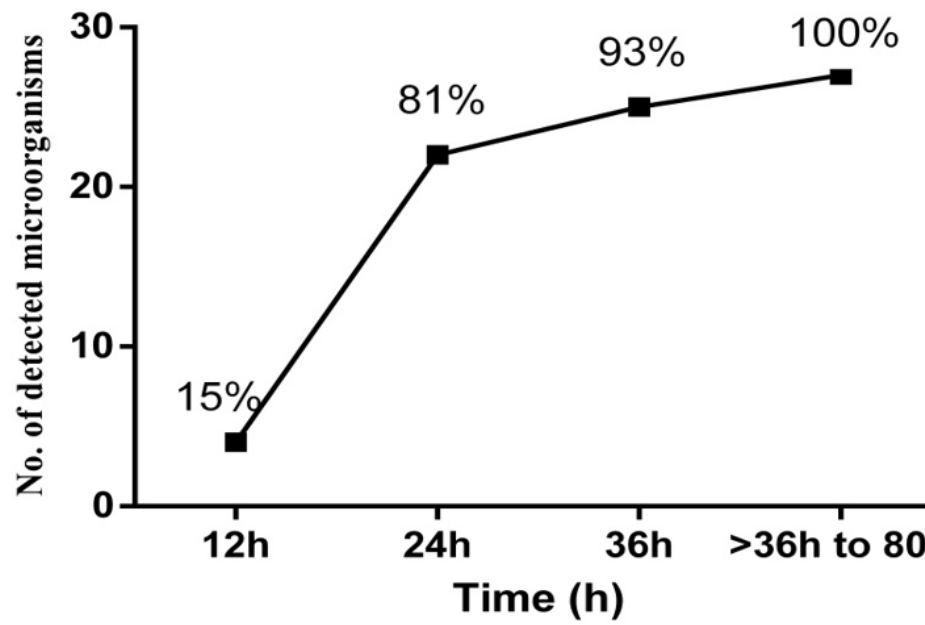
Figure 3. Time to positivity of positive blood culture bottles inoculated with sonication fluid. Due to the BCB inoculation, microbial growth was detected in 15% and 81% of the positive samples in the first 12 h and 24 h after surgery respectively. BCB-SF with sonication